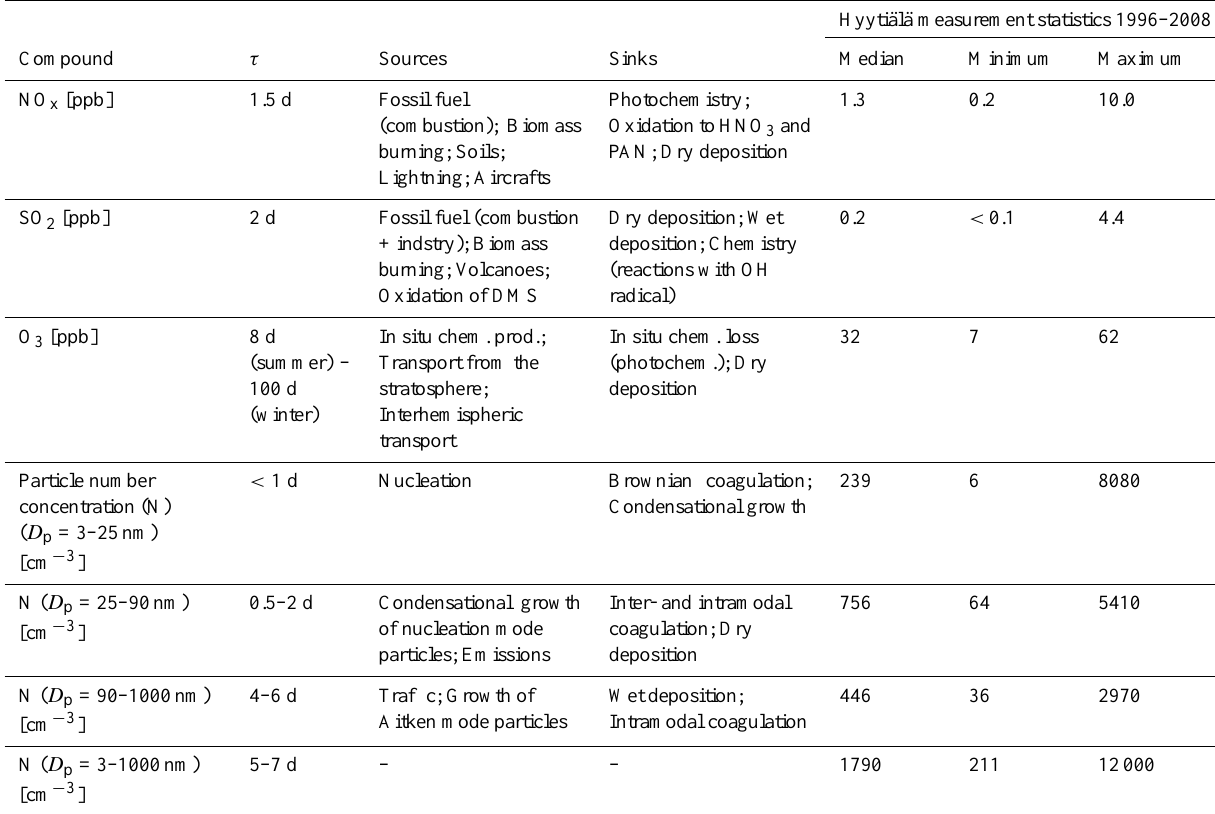
Table 1. Investigated compounds, their typical sources, sinks and estimated atmospheric lifetimes (according to Seinfeld and Pandis (1998) for trace gases and Lauer and Hendricks (2006)) for particles). Median, minimum (median of values < 1-percentile limit) and maximum (median of values > 99-percentile limit) concentrations registered in Hyyti¨al¨a